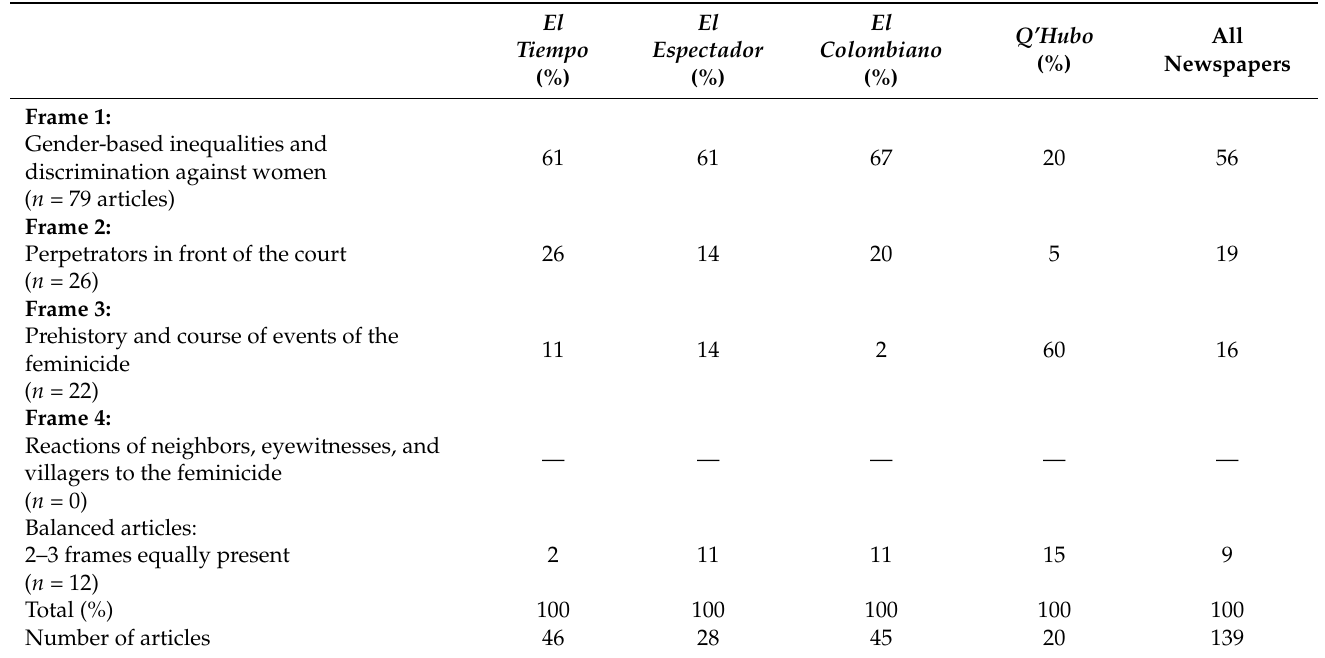
Table 3. Dominant frames per article in the four newspapers under